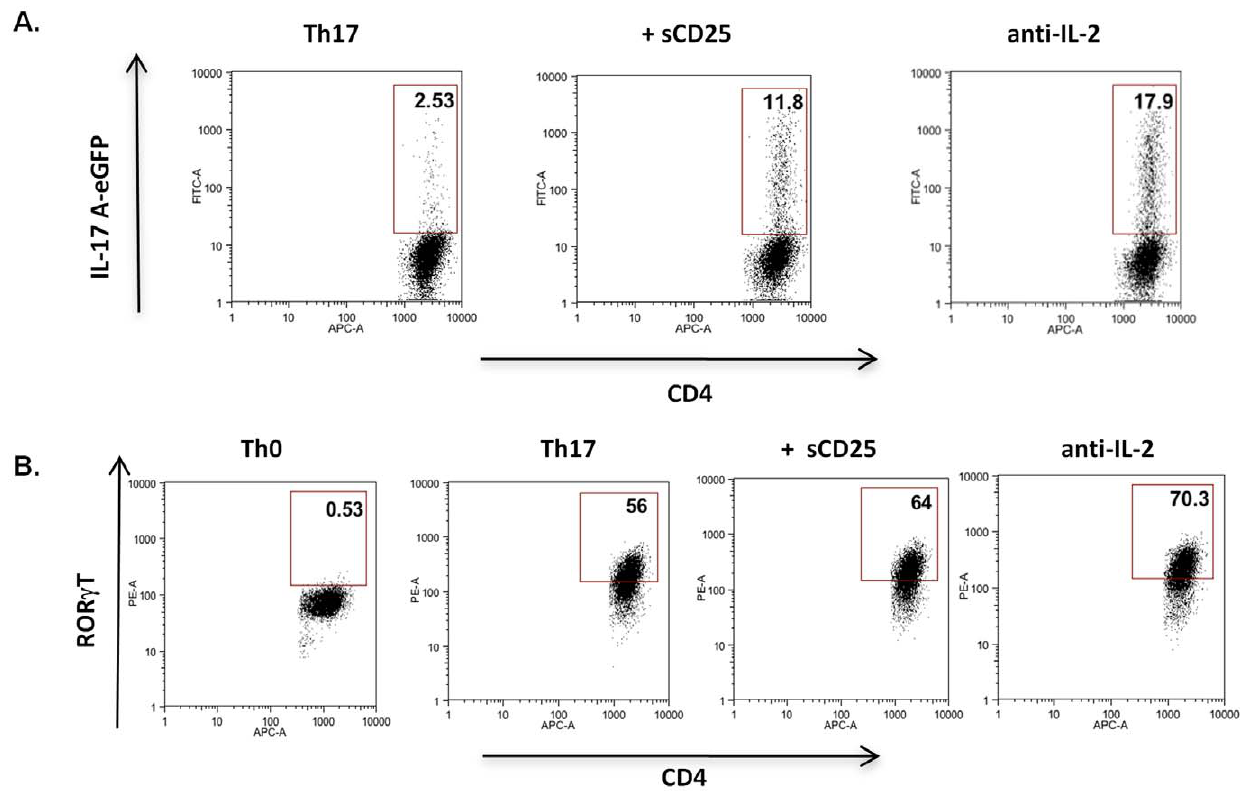
Figure 4. sCD25 acts early during Th17 development. Purified naive CD4 + T cells from IL-17AeGFP reporter mice activated under Th17 inducing conditions in the presence of sCD25 (20 m g/ml) or anti-IL-2 (10 m g/ml) for 48 hrs and examined for levels of ( A ) IL-17A and ( B ) ROR c T expression by FACS. All data are representative of at least 3 independent experiments.